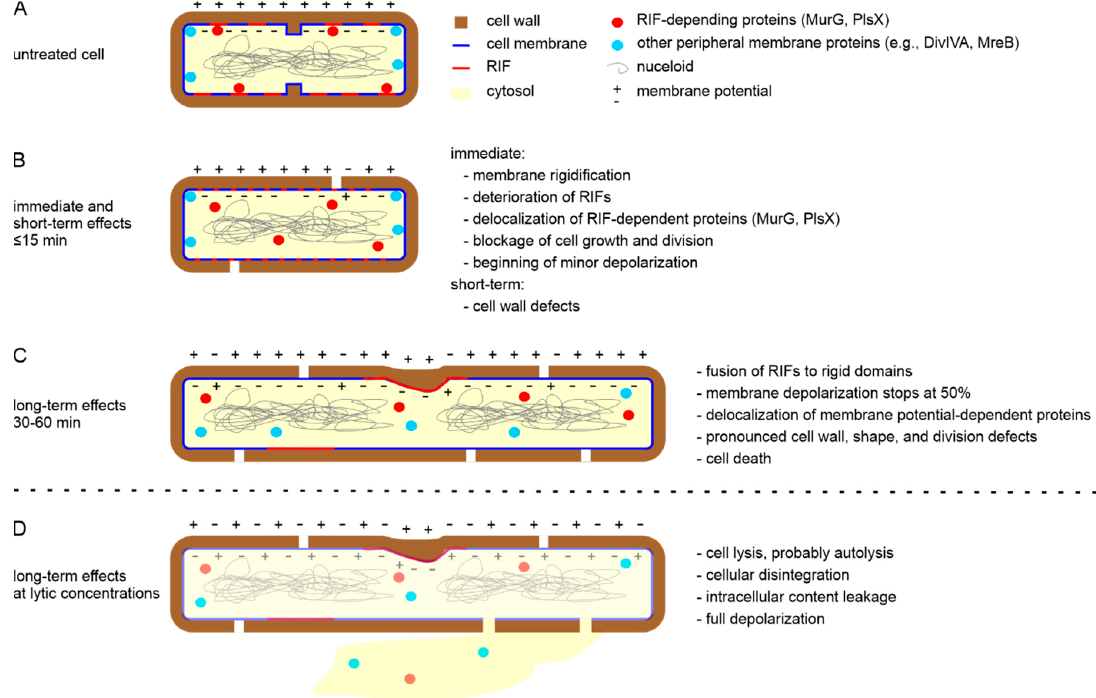
Figure 4. E ff ects of daptomycin on B. subtilis cells. ( A ) Untreated cell. ( B ) Short-term e ff ects of daptomycin (0–15 min) at bactericidal concentrations. ( C ) Long-term e ff ects of daptomycin (30–60 min) at bactericidal concentrations. ( D ) Long-term e ff ects of daptomycin (30–60 min) at bacteriolytic concentrations.